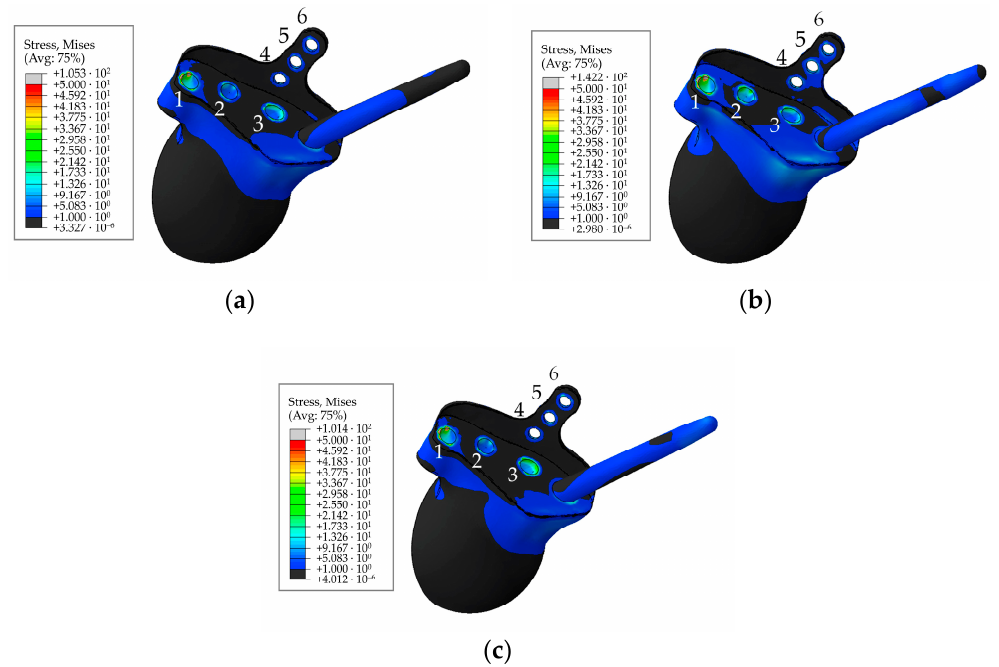
Figure 26. Stress distribution for a pretension force of 50 N and the hole numbering convention in implant: ( a ) in 63% phase; ( b ) for ascending stairs; ( c ) for descending stairs, MPa.